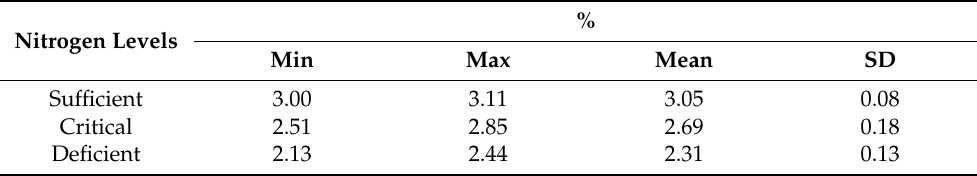
Table 3. Results of the descriptive statistics of the chemical analysis of N content in plants located in the sampling points, considered as N-sufficient, -critical and -deficient.